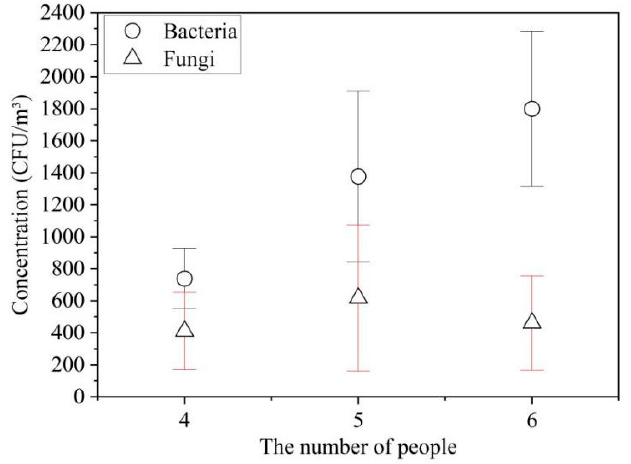
Figure 5. Relationship between the concentrations of microbes and the number of female occupants in the dormitory.